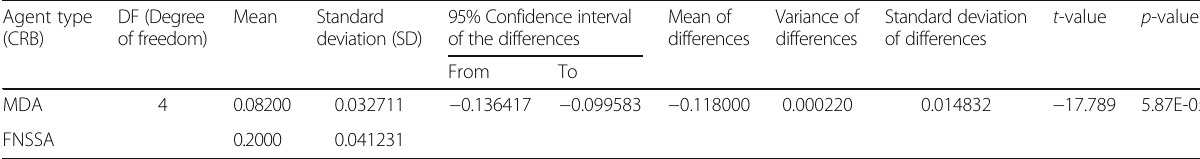
Table 12 Significant results of t-test statistical method for success rate metric in marketplaces which are made based on Market_SS2 Agent type